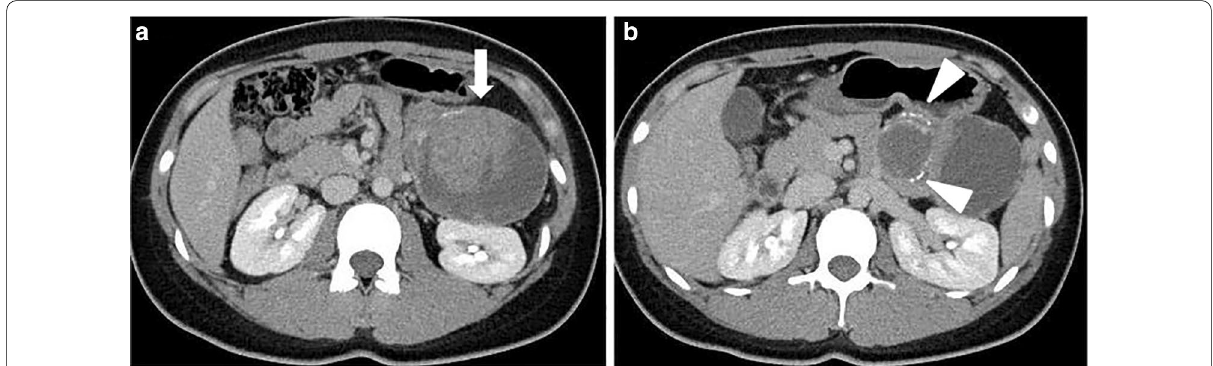
Fig. 2 Abdominal computed tomography scan images. A 10-cm clearly demarcated tumor (arrow) with solid and cystic components are seen in the pancreatic tail ( a ), and the capsule had calcifications (arrowhead) ( b